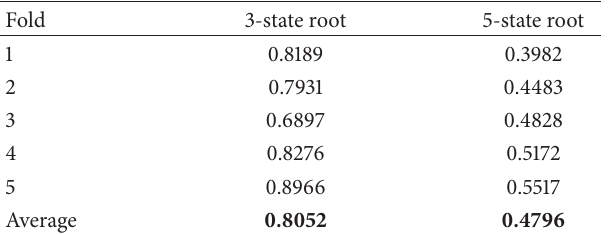
Table 5: The classification accuracy of the Bayesian